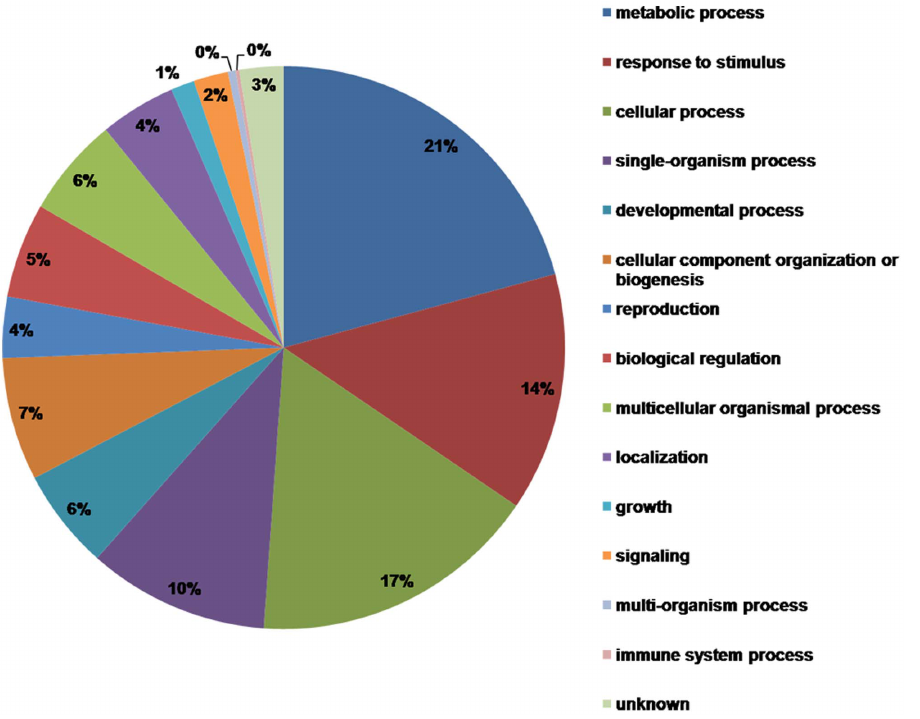
Figure 6. Protein function category.